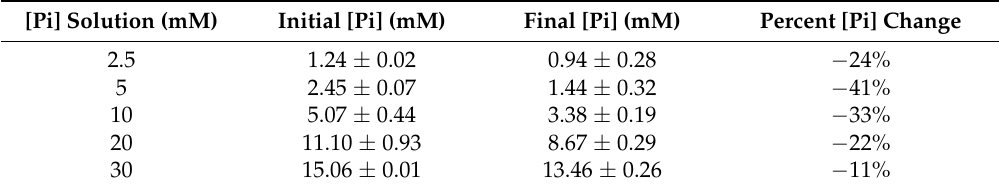
Table 3. Summary of [Pi] results for the batch, unseeded precipitation tests.